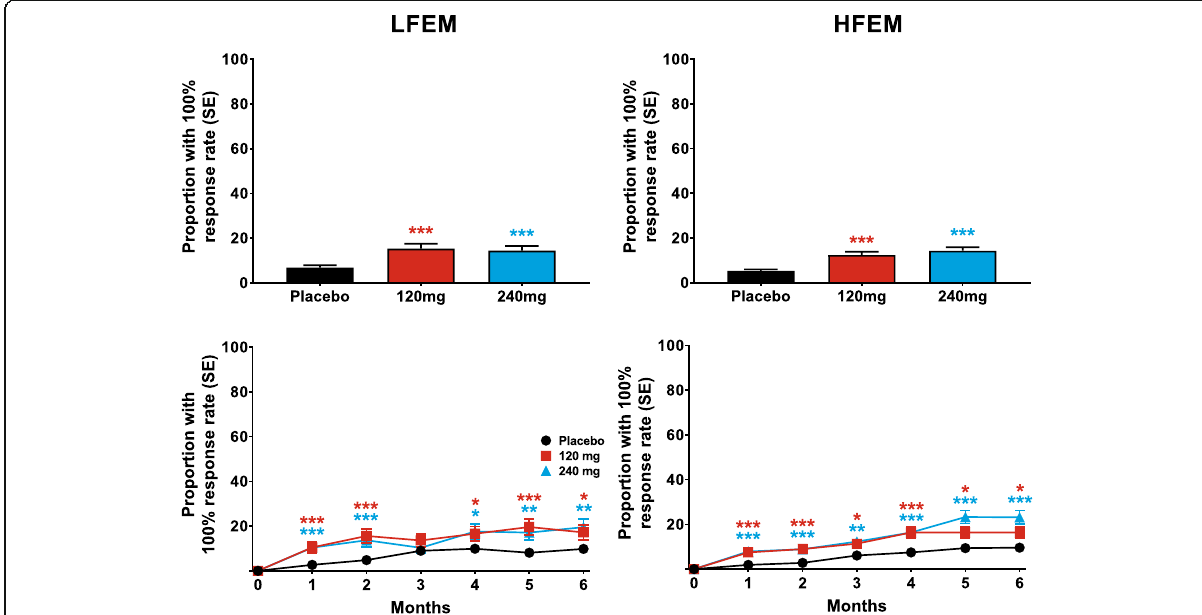
Fig. 4 The overall mean percentage of patients with 100% reduction in monthly MHDs across Months 1 – 6 is shown for patients with LFEM and HFEM receiving placebo, 120-mg, or 240-mg of galcanezumab in the upper row. The monthly percentage of patients with 100% reduction in MHDs is shown in the bottom row for patients with LFEM and with HFEM. ***p ≤ .001, **p ≤ .01, *p ≤ .05 vs